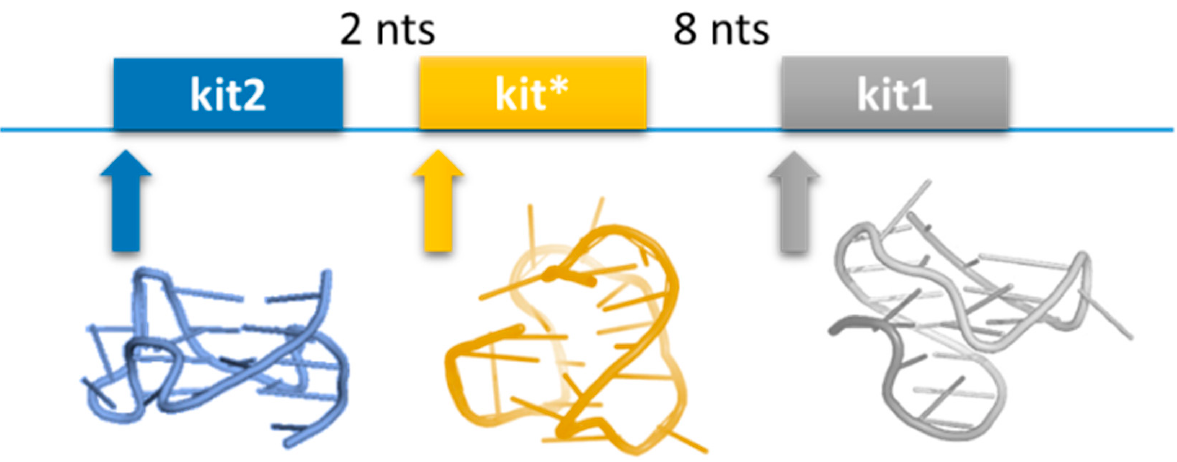
Figure 2. Schematic representation of the proximal promoter of KIT with the G4 structures that can form within this region (kit2: PDB 2KYP; kit*: PDB 6GHO; kit1: PDB 2O3M). Finally, kit1, kit2, and kit* are closely located, with only a few nucleotides separating each